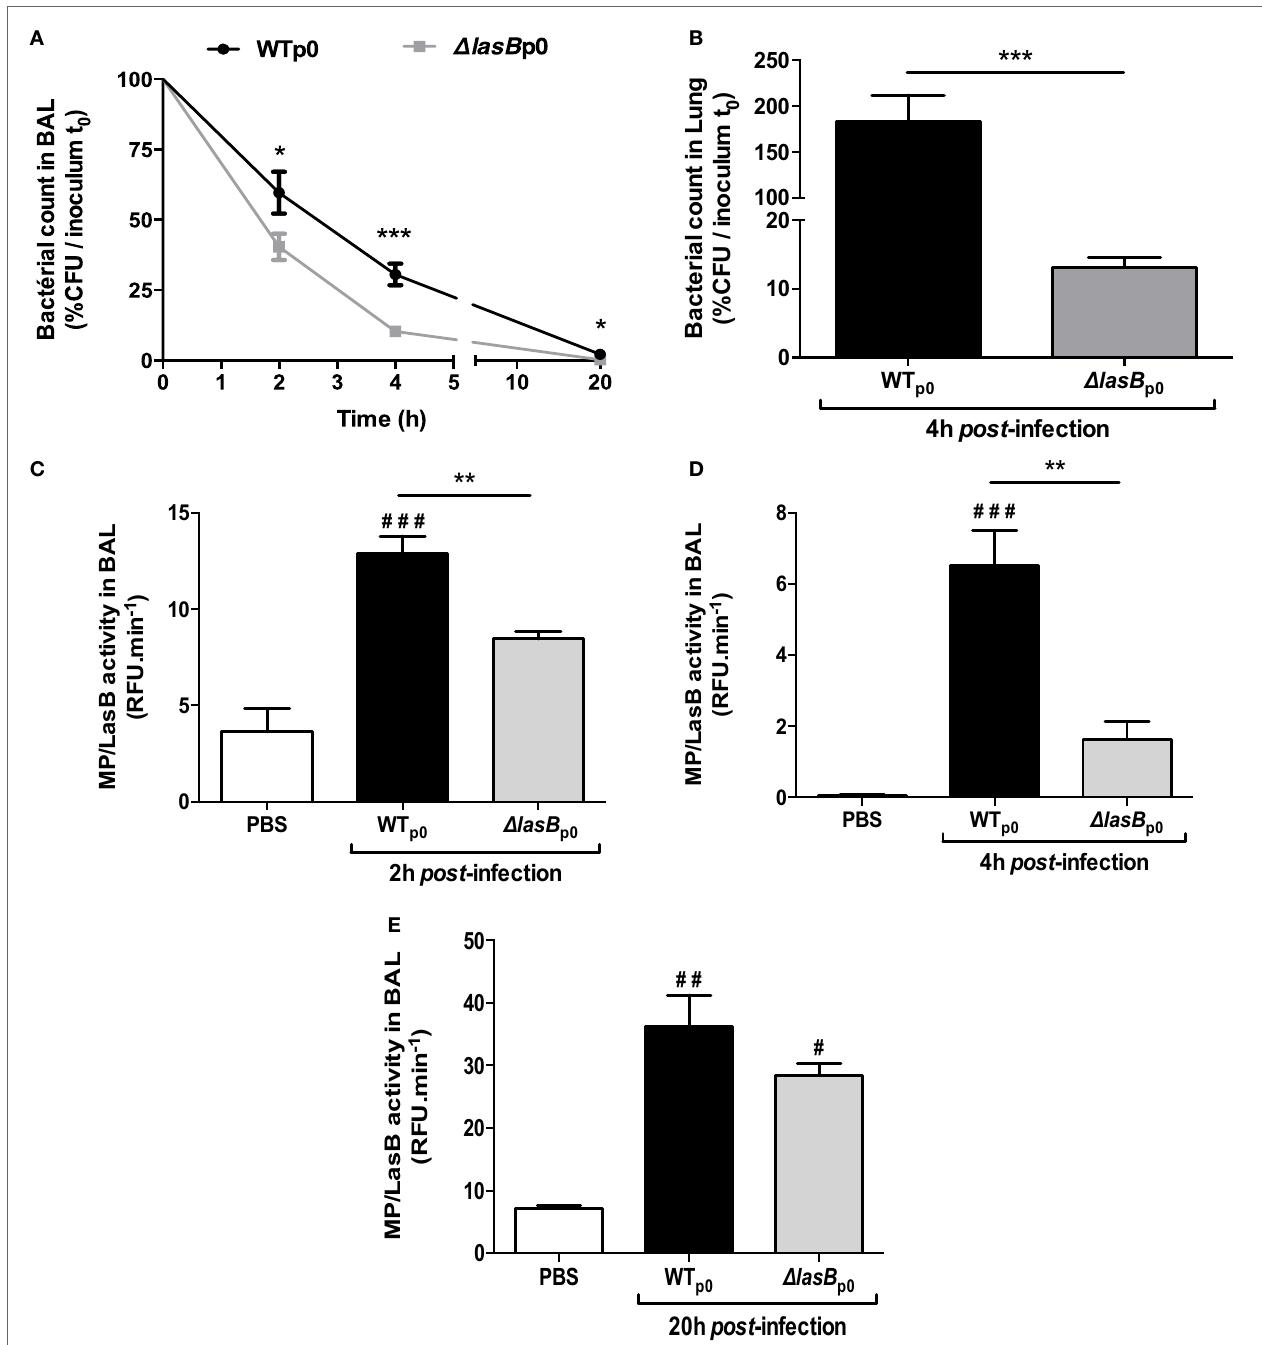
FigUre 2 | In vivo bacterial clearance and enzymatic measurements. C57/Bl6 mice (7 ≤ n ≤ 17) were infected i.n with WT-PAO1 or Δ LasB-PAO1 (5 × 10 6 cfu), and bacterial growth (a,B) , metalloprotease activity (c–e) were measured in lung extracts and in BAL fluid, as explained in Section “Materials and Methods.” (a) Results are expressed as means ± SEM, and statistical significance assessed by Mann–Whitney test. Statistical significance between WT- and Δ LasB at each time point: * p < 0.05; *** p < 0.001; (B) results are expressed as means ± SEM, and statistical significance assessed by Mann–Whitney test: *** p < 0.001; (c) results are expressed as means ± SEM, and statistical significance assessed by a Kruskal–Wallis test, followed by Dunn’s post- analysis. ** p < 0.01 compared to WT-PAO1; ### p < 0.001, compared to PBS; (D) same representation and statistical analysis as in (c) ** p < 0.01, compared to WT-PAO1; ### p < 0.001, compared to PBS; (e) same representation and statistical analysis as in (c) # and ## : p < 0.05 and 0.01, respectively, compared to